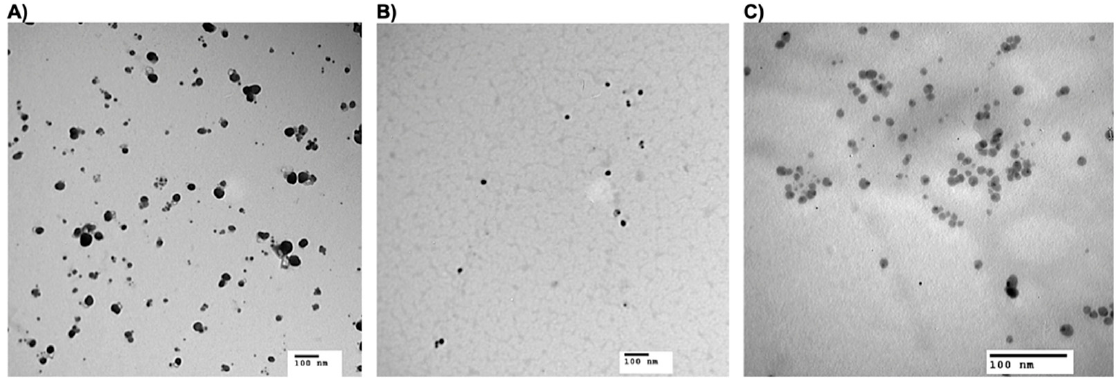
Figure 2. Transmission electron micrographs for AgNPs-EC ( A ), AgNPs-PVP ( B ), and AgNPs-PEG ( C ). The scale bar represents 100 nm.